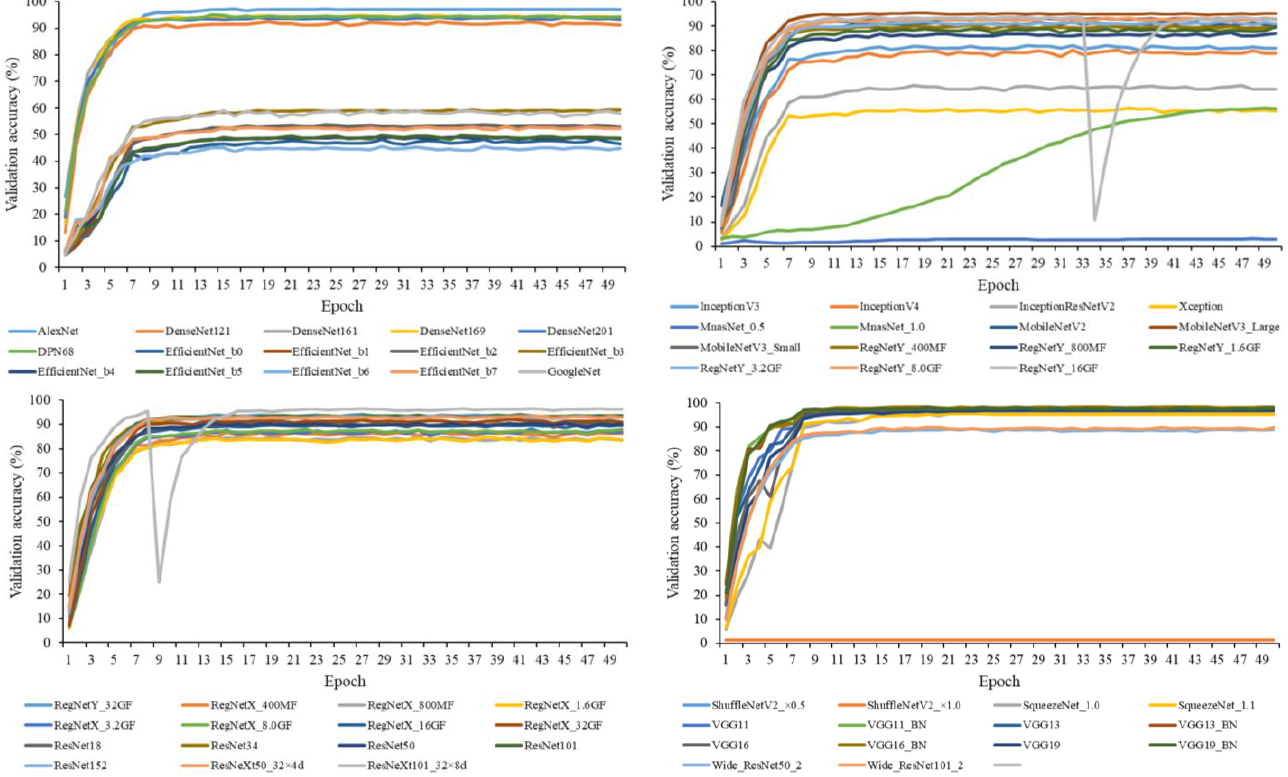
Figure 4. Validation accuracy of the 59 deep learning image classification models. Descriptions of the models are provided in Table 2.